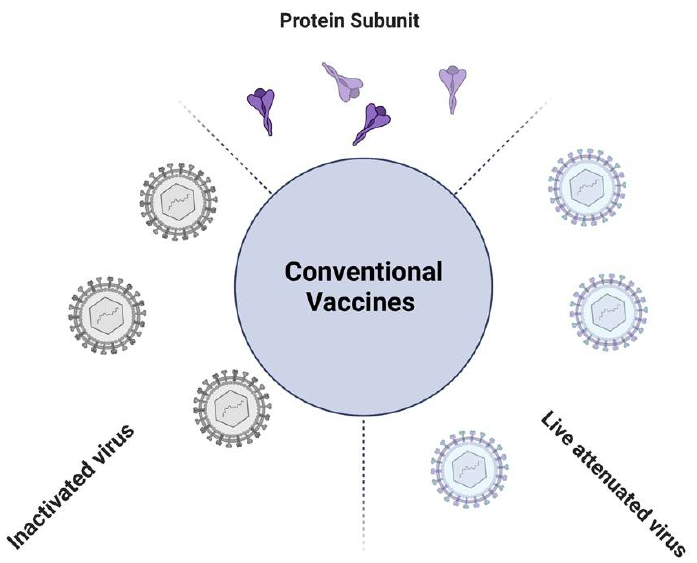
Figure 1. Illustrative figure of the currently available conventional vaccine types. Even though these vaccines have allowed for the prevention, or the control, of